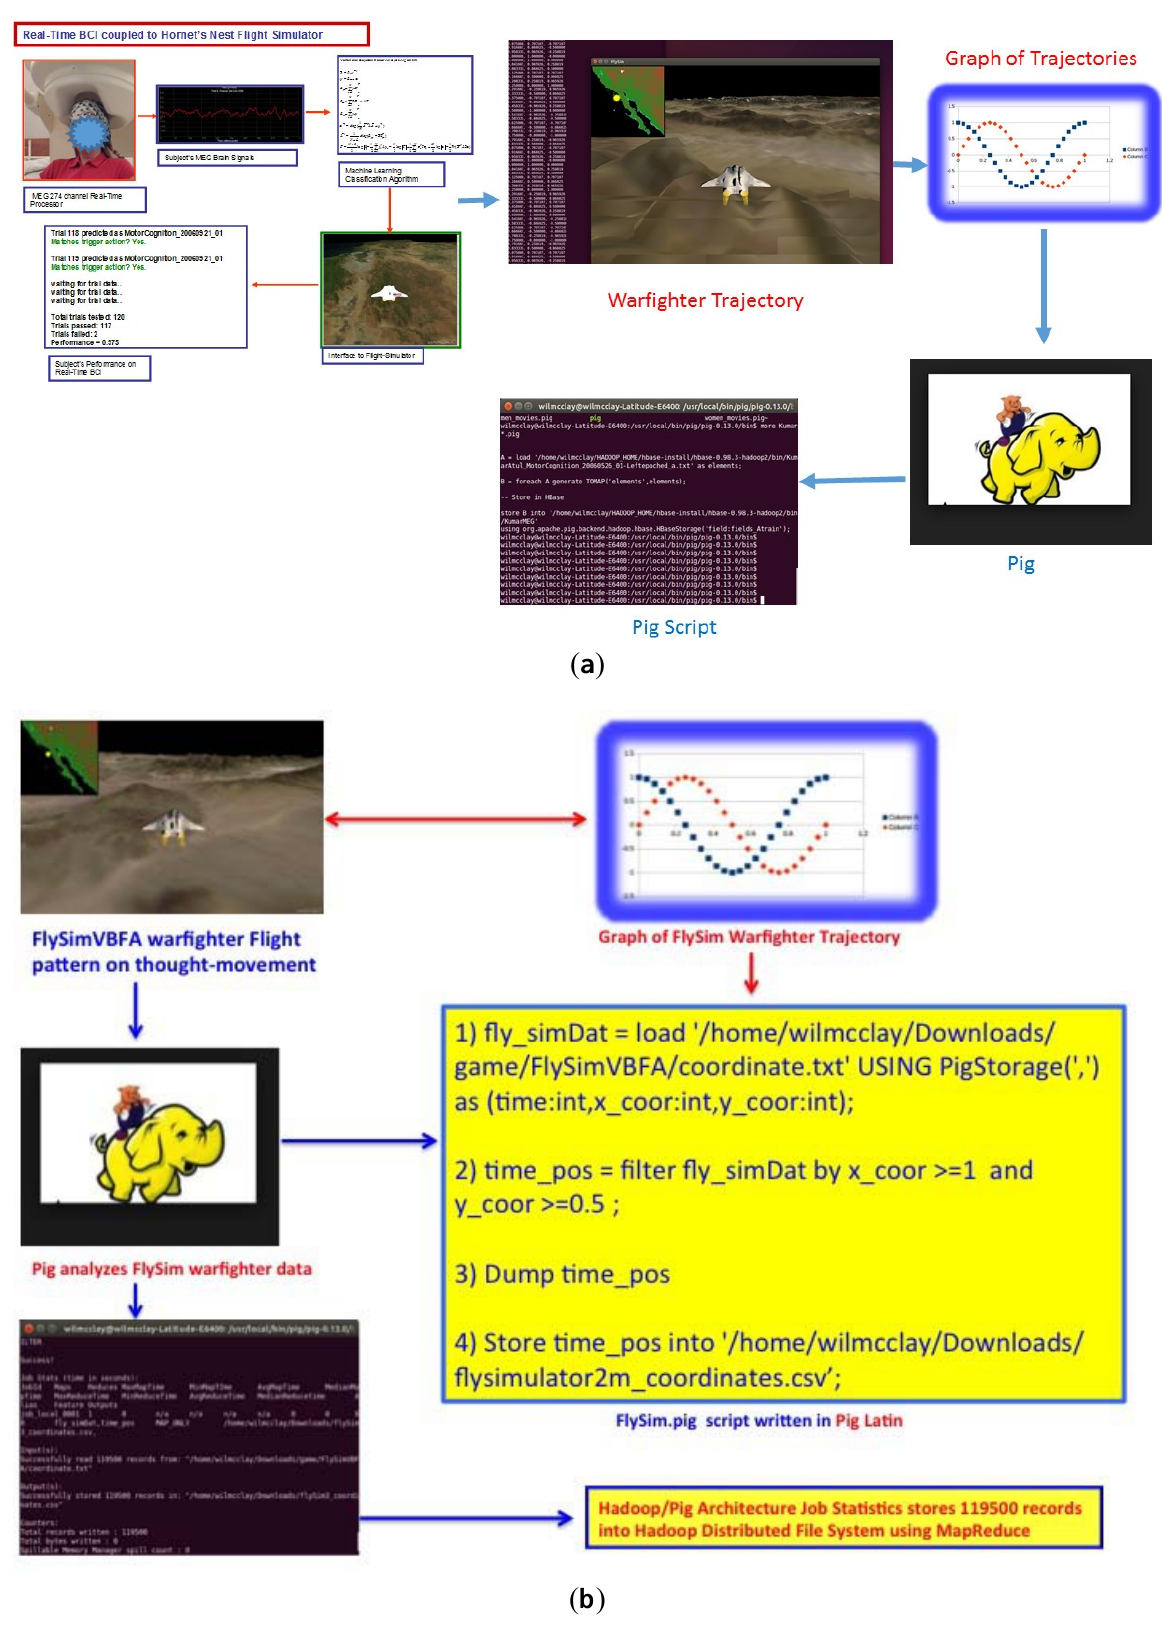
Figure 8. ( a ) Pig Scripts to analyze the warfighter’s trajectory based on subject’s thought movement; ( b ). A step-by-step analysis of the FlySimVBFA.pig script with MapReduce storing 119,500 warfighter trajectory records into the Hadoop Distributed File